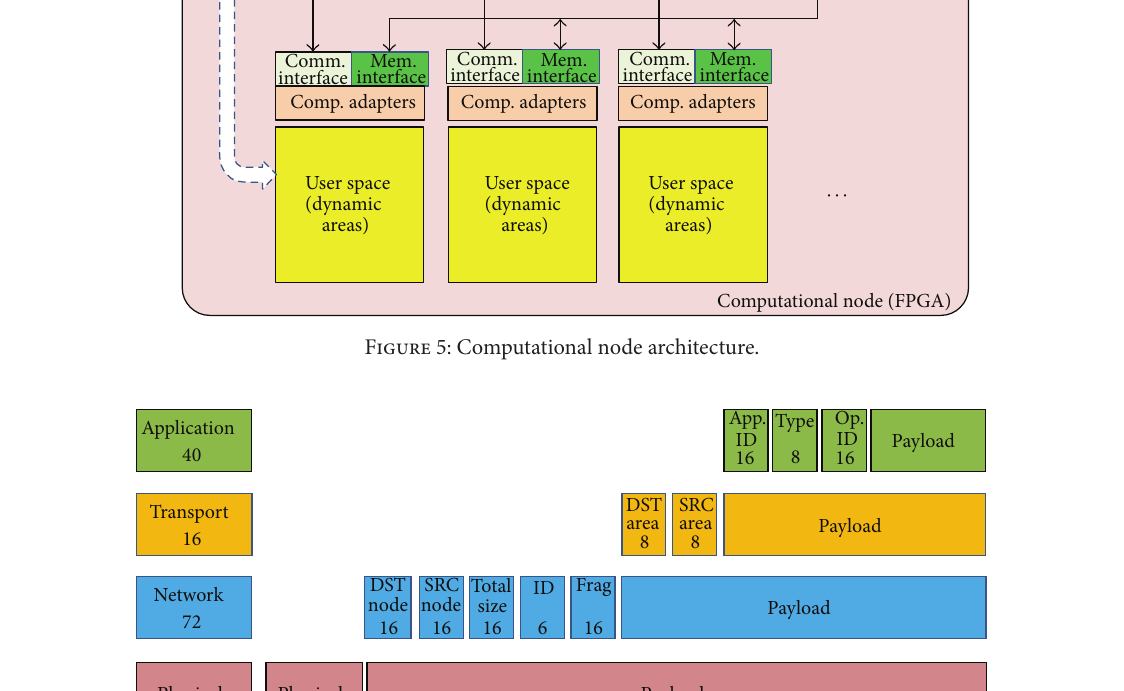
Figure 6: Network protocol